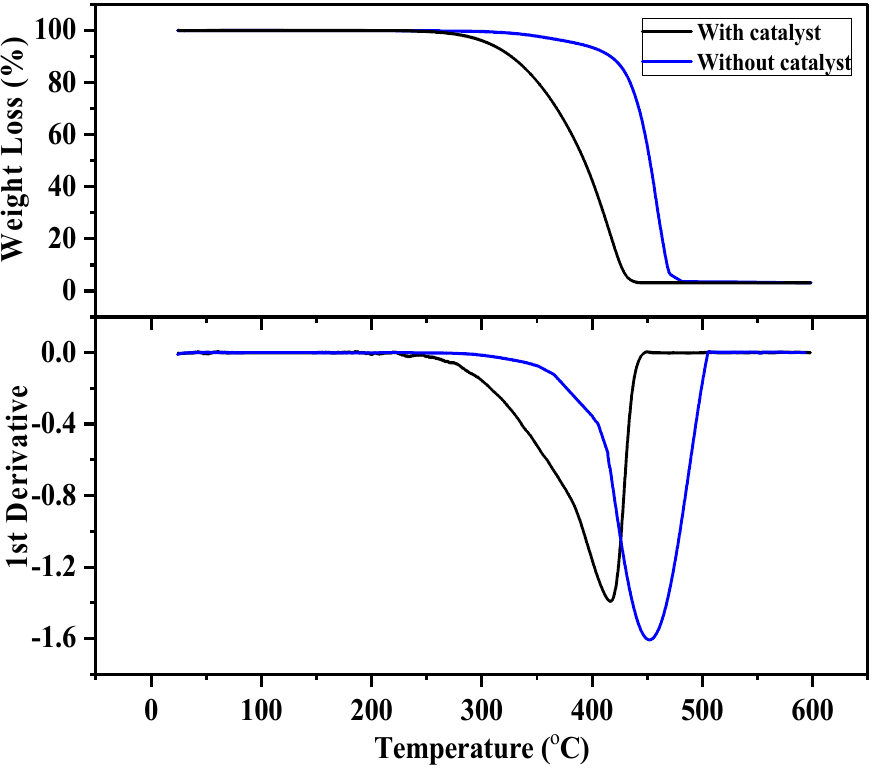
Figure 2. TG/DTG of waste PP with and without florisil at 3 ◦ C · min − 1 Figure 2 TG/DTG of waste PP with and without florisil at 3 °C·min − 1 .